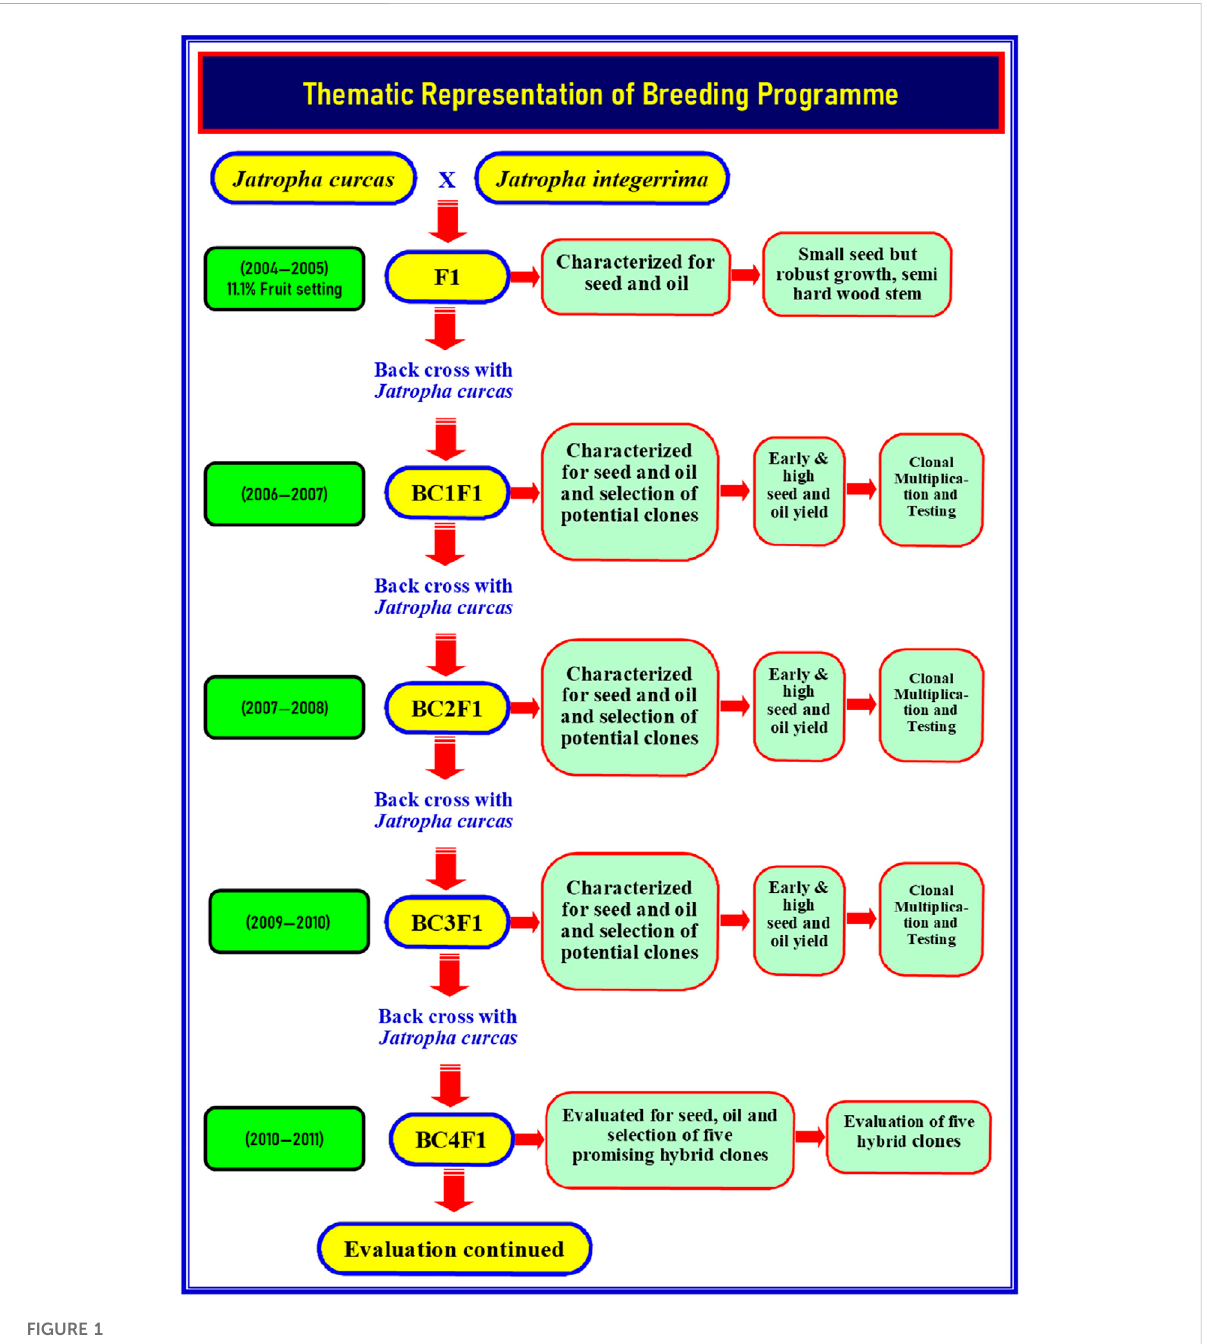
FIGURE 1 Thematic representation of breeding